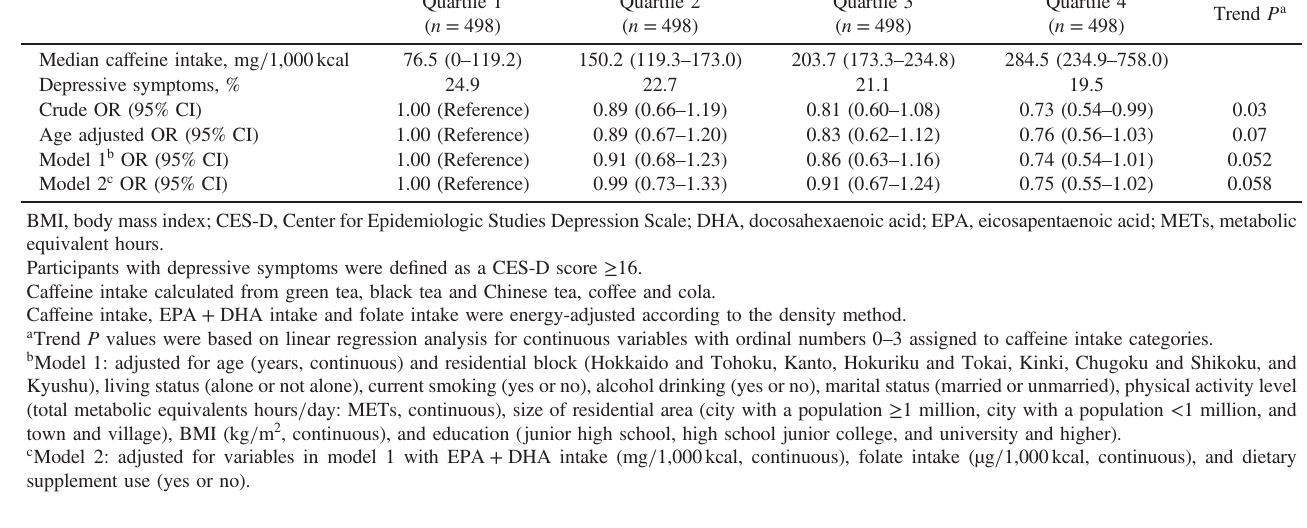
Table 3. Adjusted odds ratio (95% CI) of depressive symptoms according to ca ff eine intake in elderly Japanese women ( n = 1,992) Ca ff eine intake ( n =